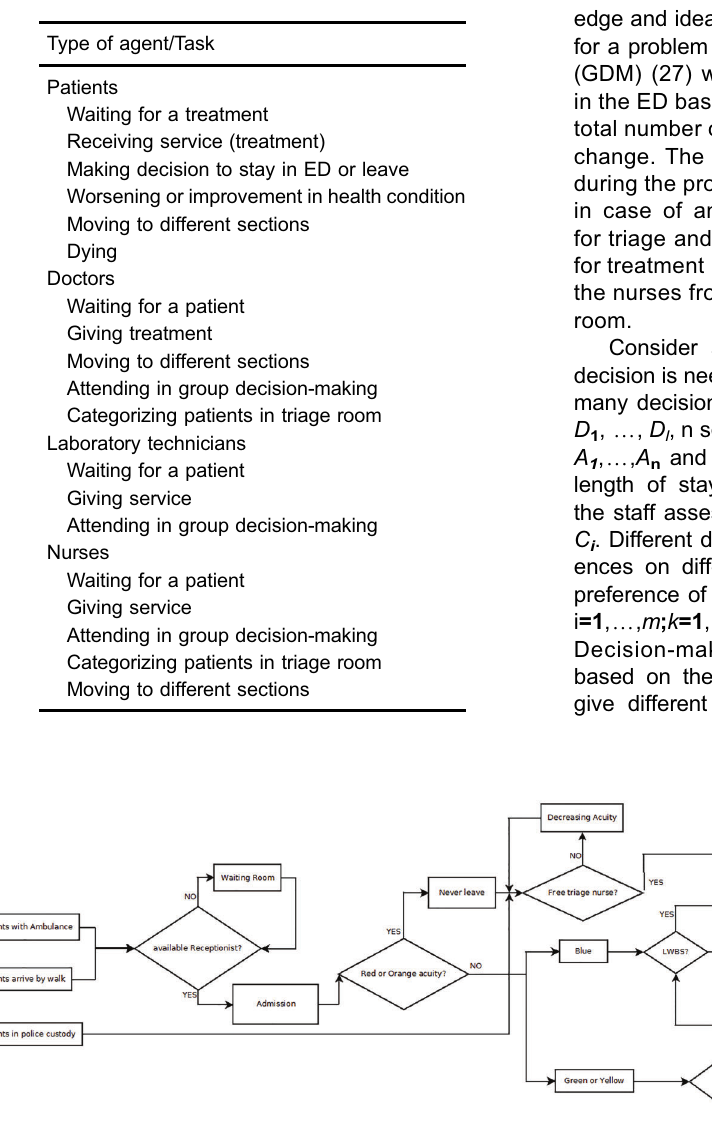
Table 1. Types of agents and their activities in an emergency department